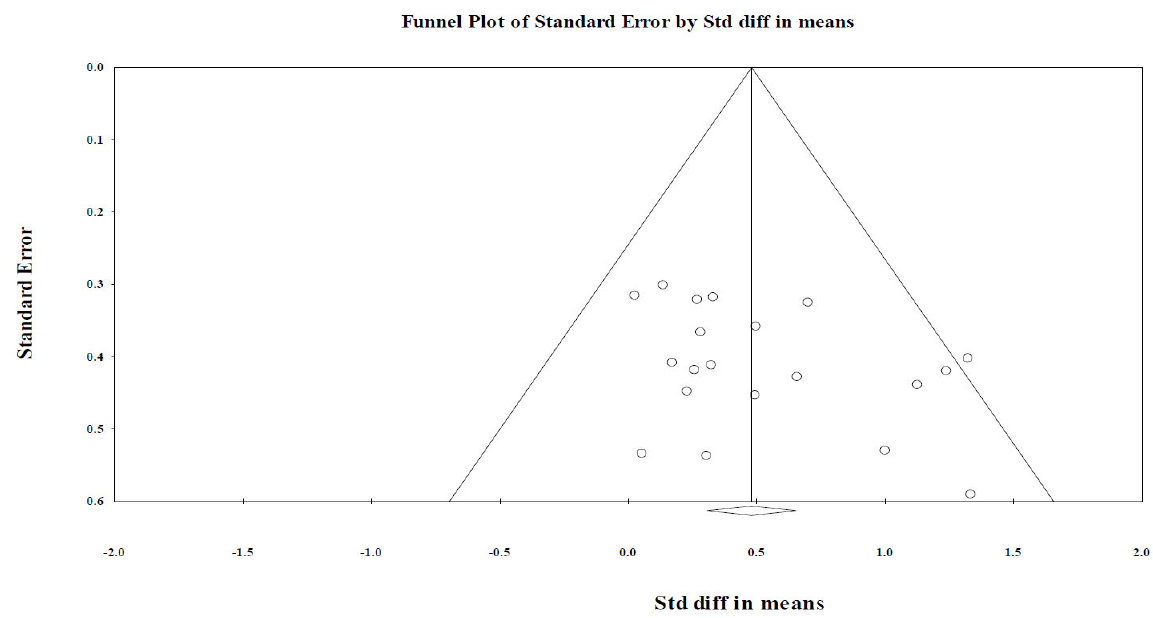
Figure 3. Funnel plot for publication bias. Std diff: standard difference.